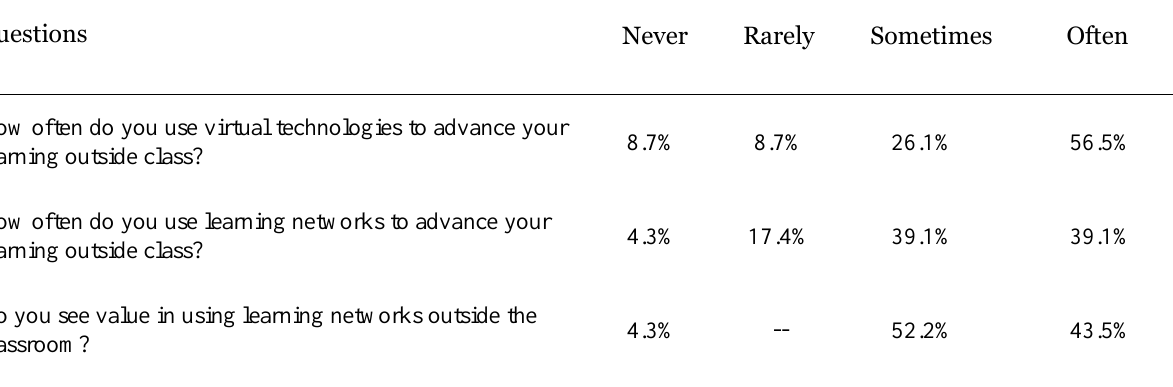
Percentage and Type of Student Informal Network Use Questions